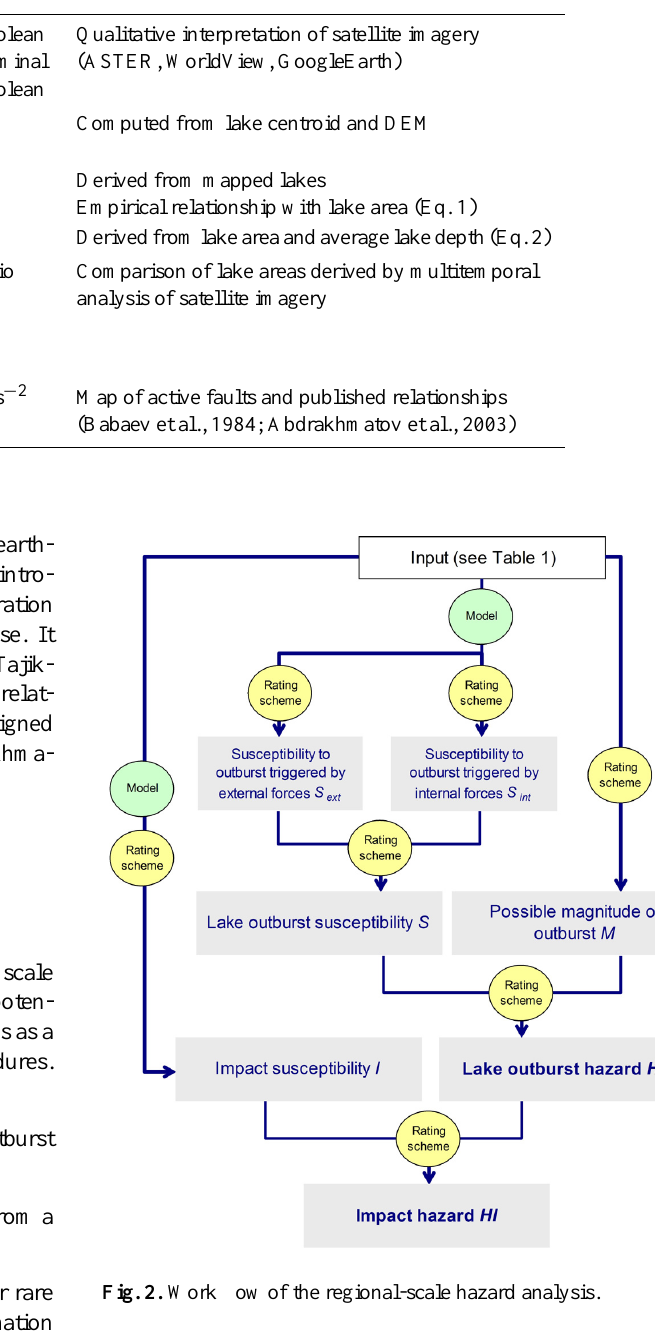
Fig. 2. Work flow of the regional-scale hazard